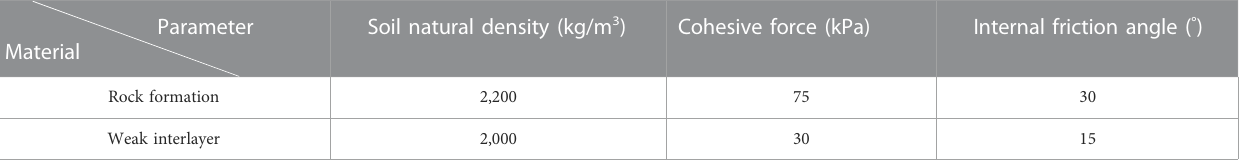
TABLE 2 Physical and mechanical parameters of materials.